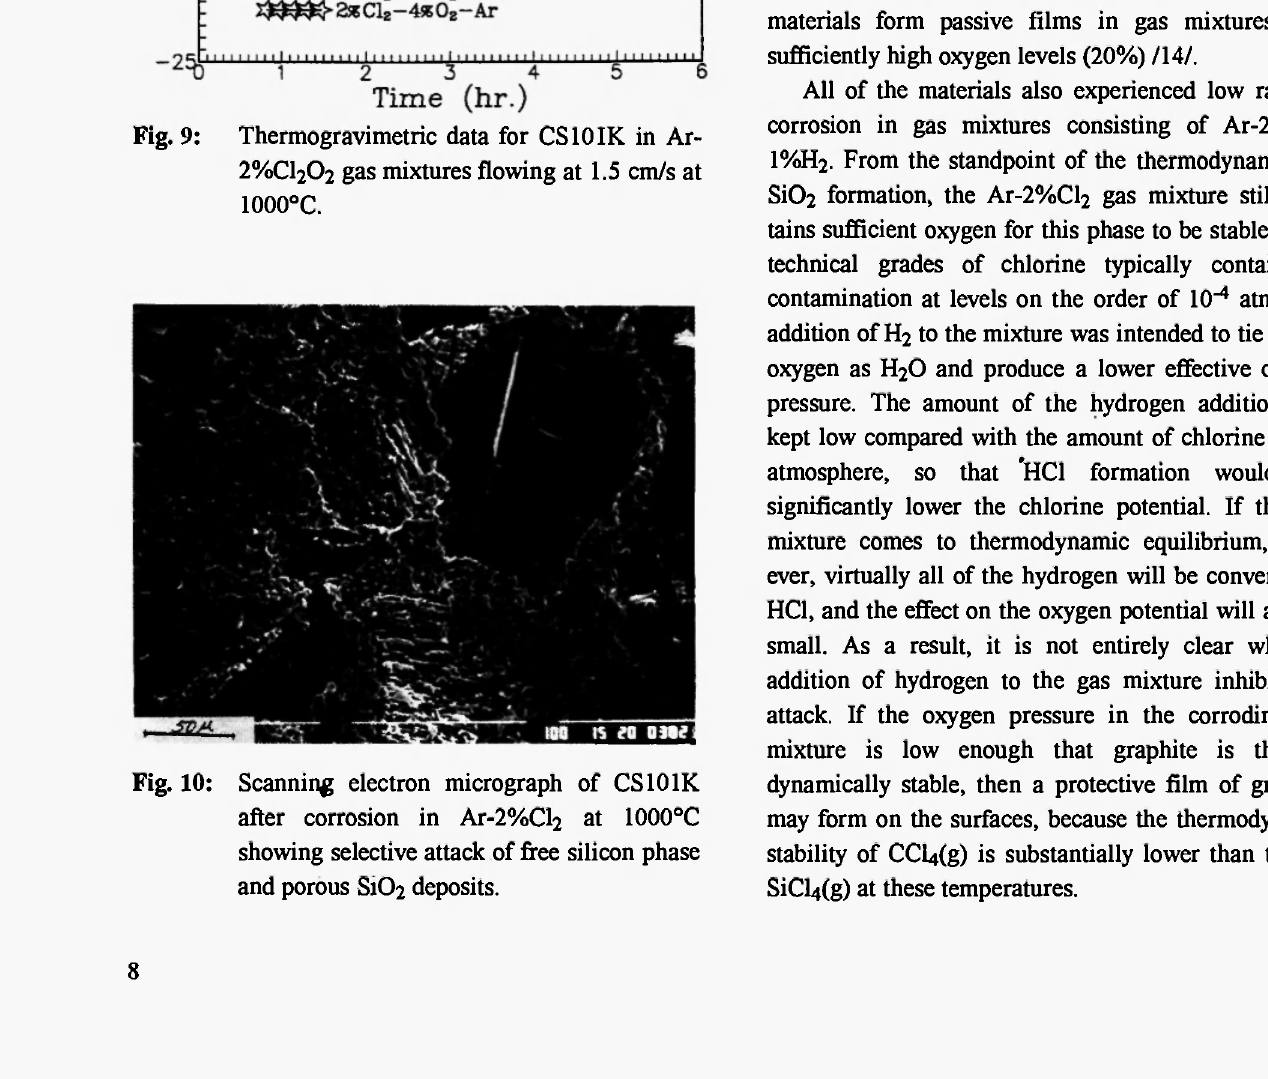
Fig. 9: Thermogravimetric data for CS 10 IK in Ar- 2%Cl202 gas mixtures flowing at 1.5 cm/s at 1000°C.